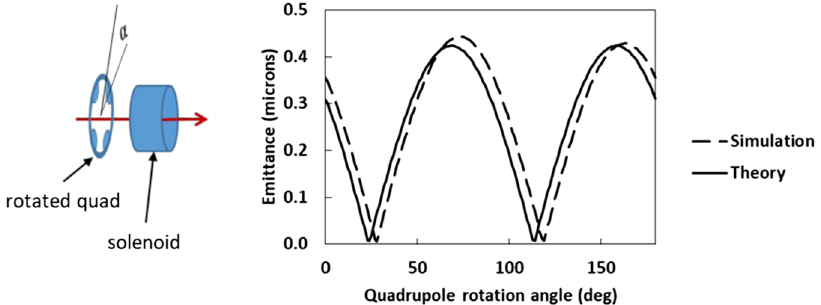
FIG. 4. The emittance growth for a quadrupole-solenoid system (shown on the left) as a function of the quadrupole rotation angle. The theory (solid line) is computed using Eq. (21) and the simulation (dashed line) is done with the GPT code. The initial beam size at the solenoid is 1 mm-rms for both the x and y planes. The quadrupole and solenoid fields are the same as Fig.